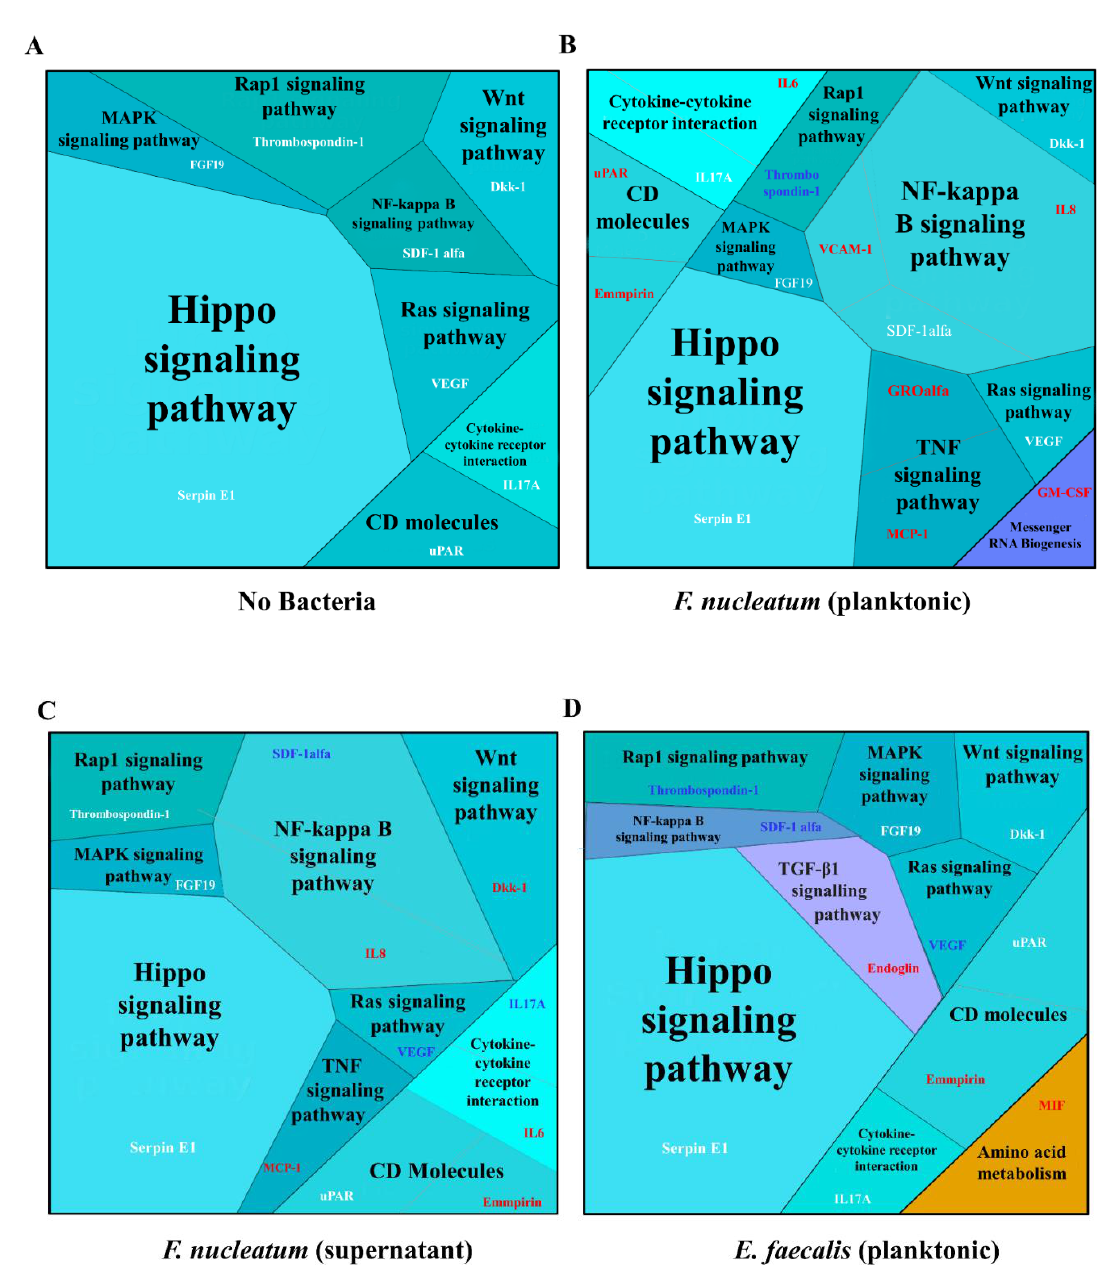
Figure 6. Proteomap predicted different signaling pathways and molecule interactions associated with SCAP modulated by oral bacteria. ( A ) No bacteria, ( B ) F. nucleatum (planktonic) , ( C ) F. nucleatum supernatants, and ( D ) E. faecalis (planktonic) with corresponding untreated control levels. Upregu- lated proteins are marked by the red text; downregulated cytokines are marked by blue text; cytokines that were secreted at a similar level as the non-treated control are marked by white text. Each protein is shown by a polygon, and functionally related proteins are arranged in common regions. To emphasize highly expressed proteins, polygon areas represent protein abundances weighted by protein size. In each Proteomap, angiogenin and pentraxin 3 are omitted.